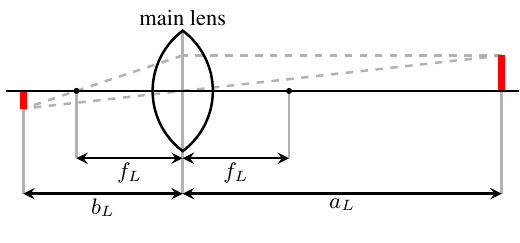
Figure 1: Optical path of a thin lens